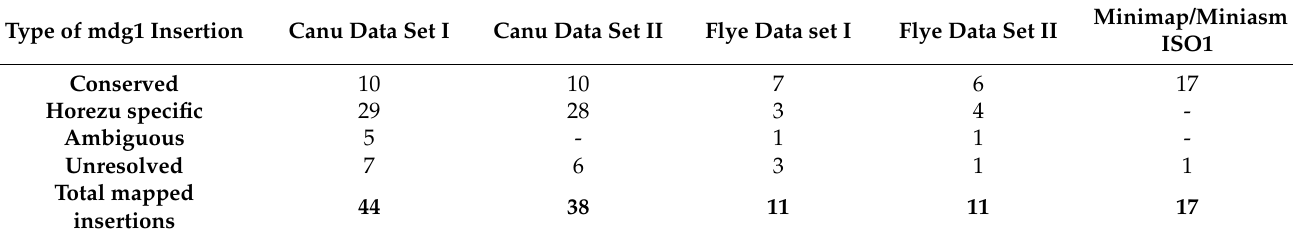
Table 5. Insertions of mdg1 in Canu—Data set I, Canu—Data set II, Flye—Data set I, Flye—Data Set II and minimap/miniasm—ISO1 genome assemblies reported by GA_v2. Insertions found